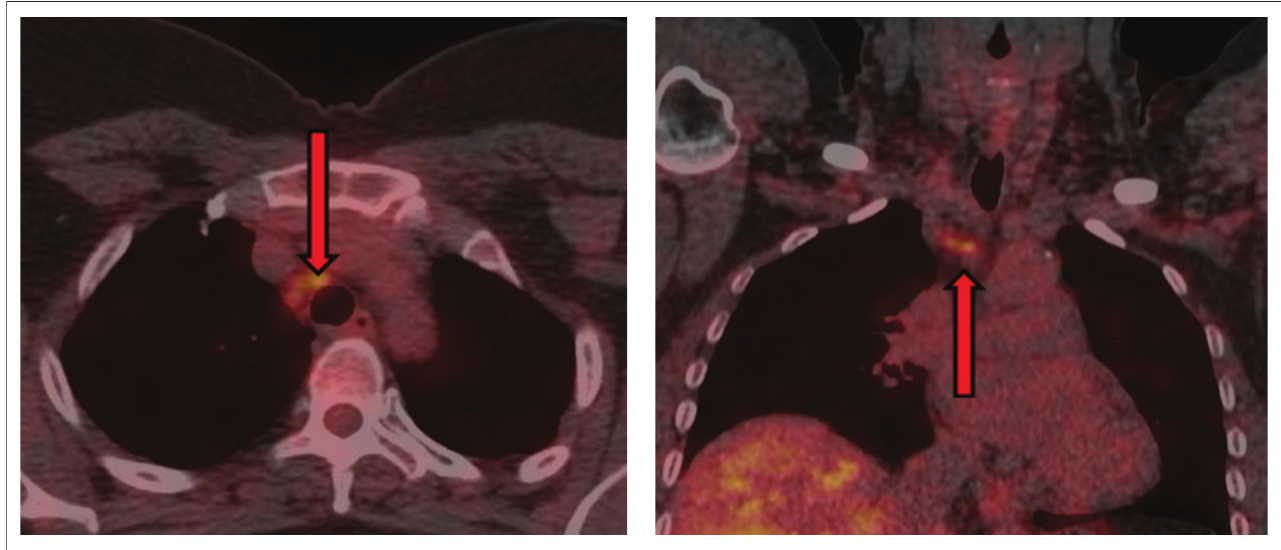
FIGURE 3: A 55-year-old with luminal disease with a station two mediastinal lymph node suspicious of metastasis on fluorodeoxyglucose positron emission tomography/ computed tomography was subjected to endobronchial ultrasound guided biopsy. SUVmax primary breast tumour = 8.4, suspected station 2 node = 3.4. Biopsy results were negative for malignancy.